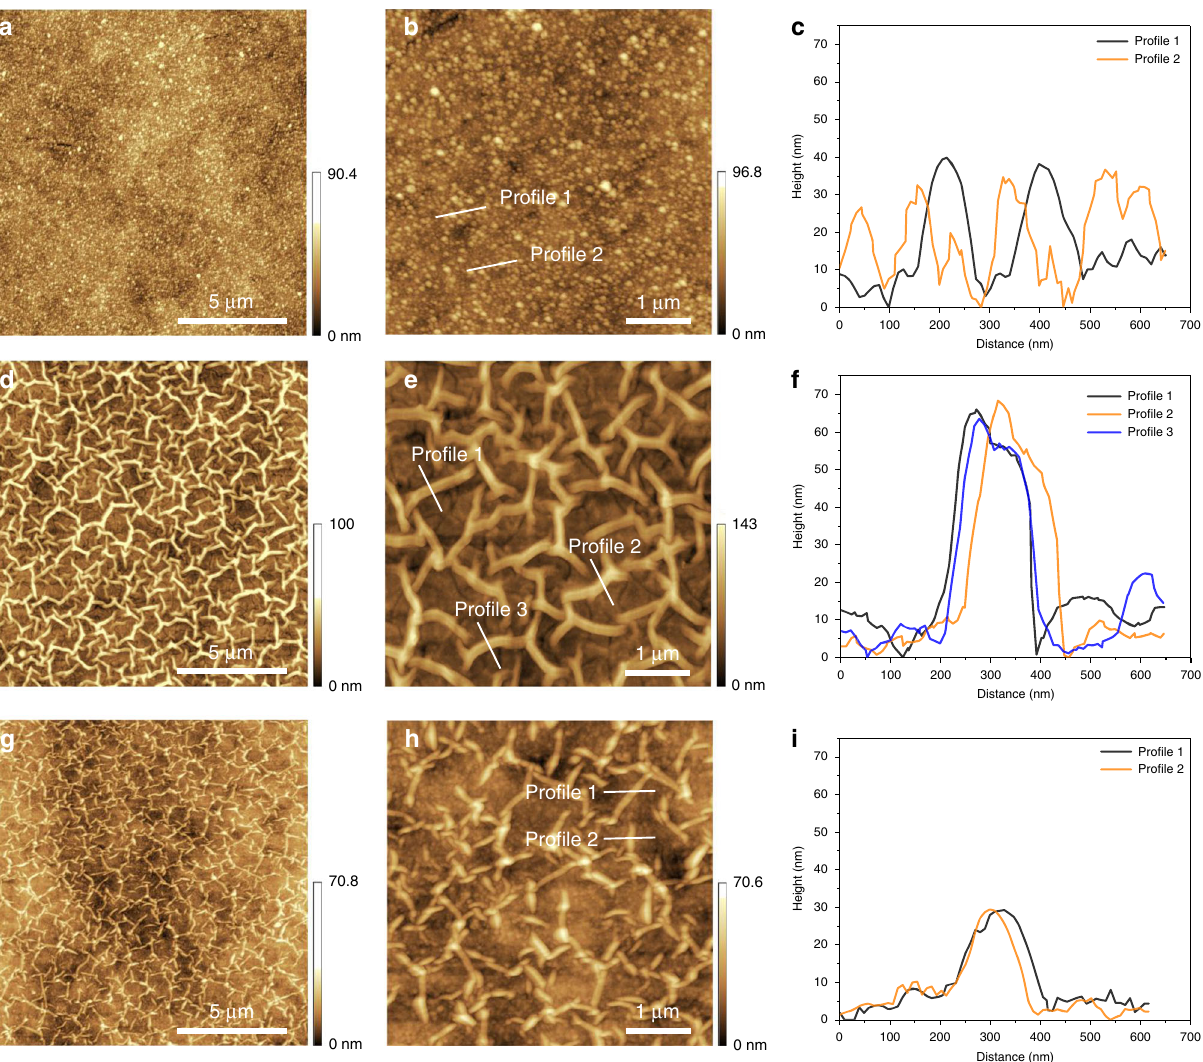
Fig. 4 Surface morphology. a – c AFM images and corresponding height pro fi les of the traditional polyamide nano fi lms. d – f AFM images and corresponding height pro fi les of the asymmetric polyamide nano fi lms with 60 s IP time. g – i AFM images and corresponding height pro fi les of the asymmetric polyamide nano fi lms with 30 s IP